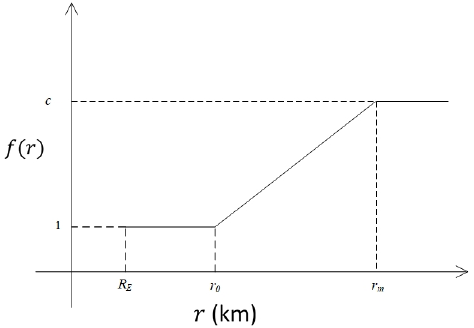
Figure 4. Graph of the proposed density modification using a linear function.